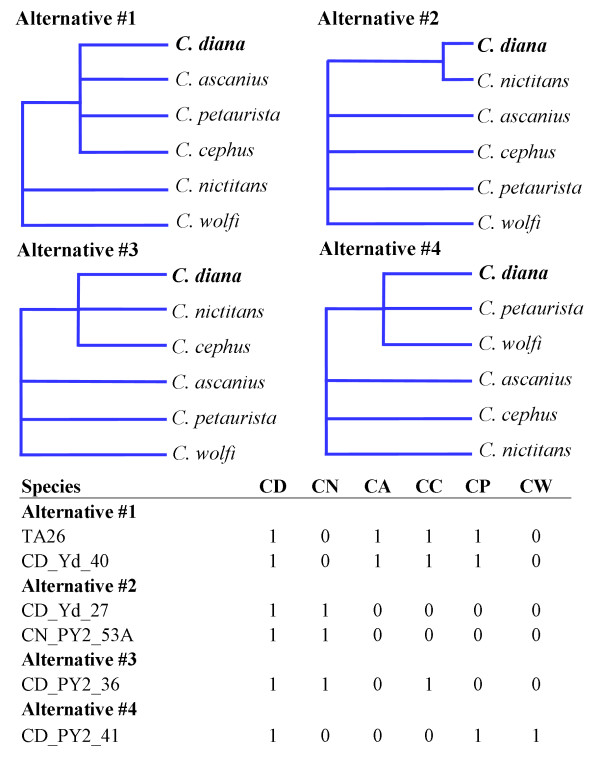
Alu insertions support different phylogenetic hypotheses for the affiliation of C. diana. Four alternative hypotheses and the markers supporting each hypothesis are shown. Presence of the insert was coded as "1" and absence of the insert as "0". CD, C. diana; CN, C. nictitans; CP, C. petaurista; CA, C. ascanius; CC, C. cephus; CW, C. wolfi.